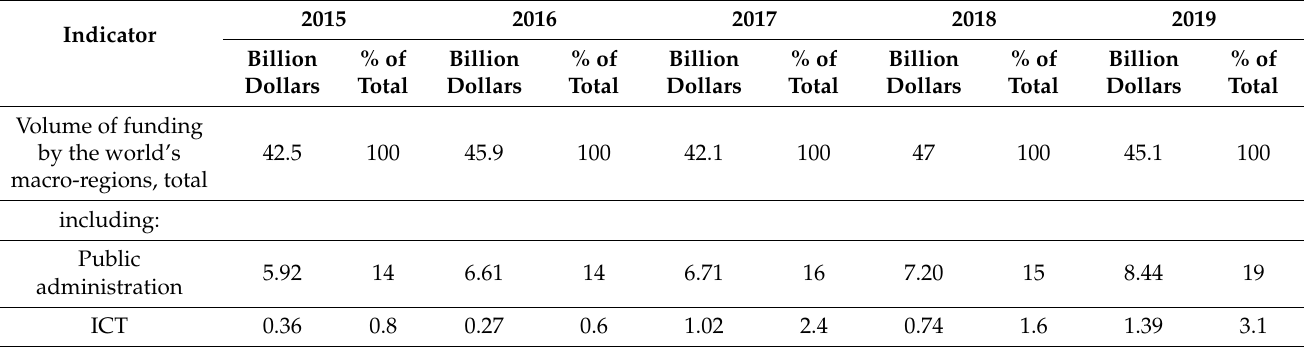
Table 2. Reserved World Bank funds by sectors of the economy in 2015–2019, billion dollars, percentage.